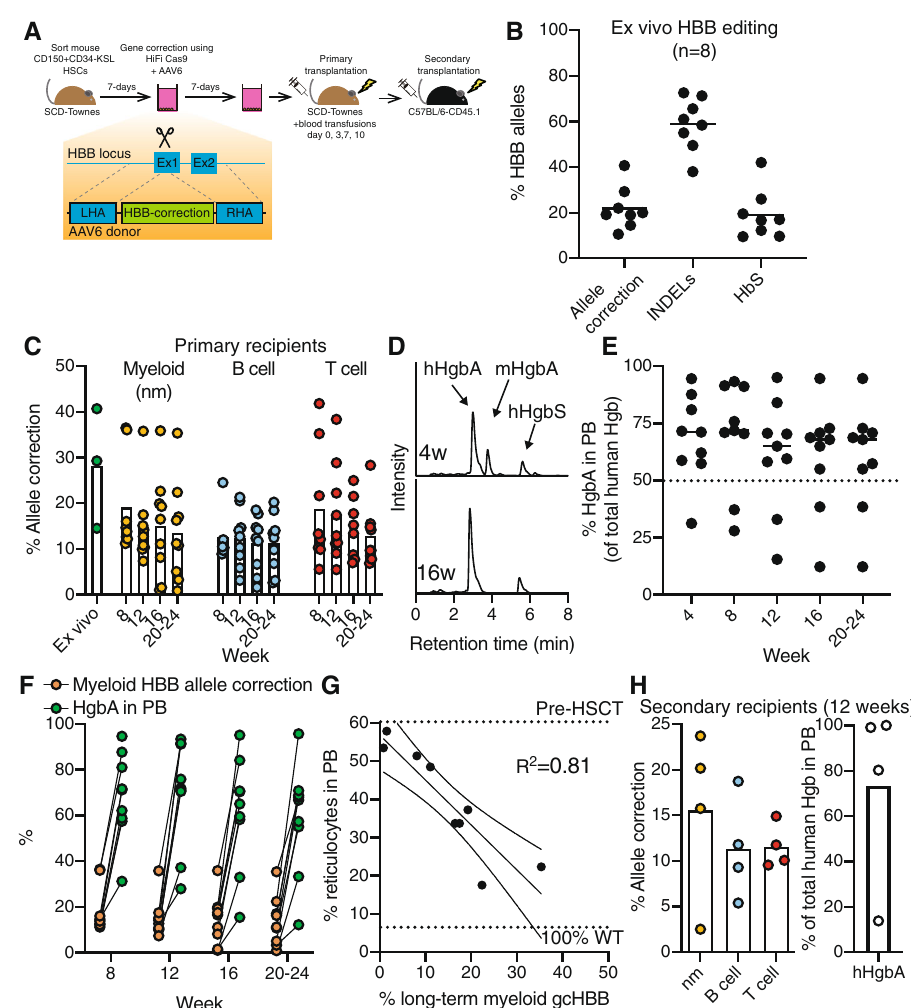
Fig. 2 Stable HgbA production in SCD mice autologously transplanted with E6V-corrected HSPCs. A Experimental schematic for Cas9-AAV6-based gene correction of the E6V mutation in beta-globin in Townes-SCD mouse HSPCs. B Mean HBB gene editing outcomes in mouse HSPC cultures from 8 biological replicates. C Mean HBB allelic correction frequencies in PB myeloid (nm), B cell, and T cell lineages over time in primary recipients ( n = 9 mice). D Representative HPLC plots for hemoglobin tetramer analysis from PB collected at 4- and 16-weeks post-transplantation, with mouse HgbA (mHgbA), human HgbA (hHgbA), and human HgbS (hHgbS) annotated. E Mean frequency of hHgbA (of total hHgbA and hHgbS) in HSCT recipients ( n = 9 mice). Dotted line represents 50% hHgbA. F Mean frequency of PB myeloid (nm) HBB allelic correction and hHgbA over time in HSCT recipients ( n = 9 mice). G X – Y linear correlations between PB reticulocyte frequency and myeloid (nm) gene correction at 16-weeks post-transplantation ( n = 9 mice). H Mean frequency of HBB allelic correction in PB leukocyte populations (left plot) and frequency of human HgbA in the PB as a total of human Hgb (right plot) in secondary recipients at 12-weeks post-transplantation ( n = 4 mice). 1 × 10 6 WBMCs from mouse A or mouse B (see Table 1) were transplanted into recipient mice (2 mice per primary recipient). Source data are available in the Source data fi